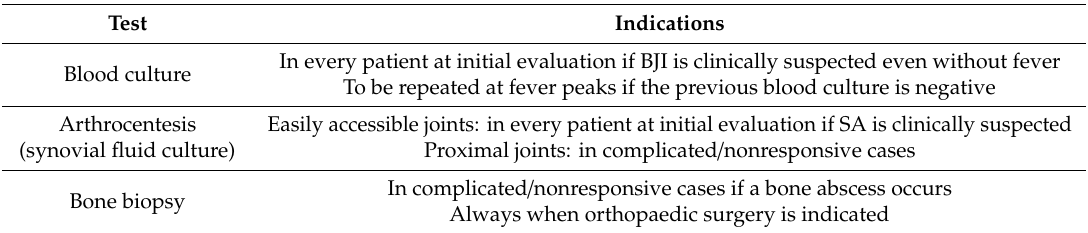
Table 3. Indications for microbiological